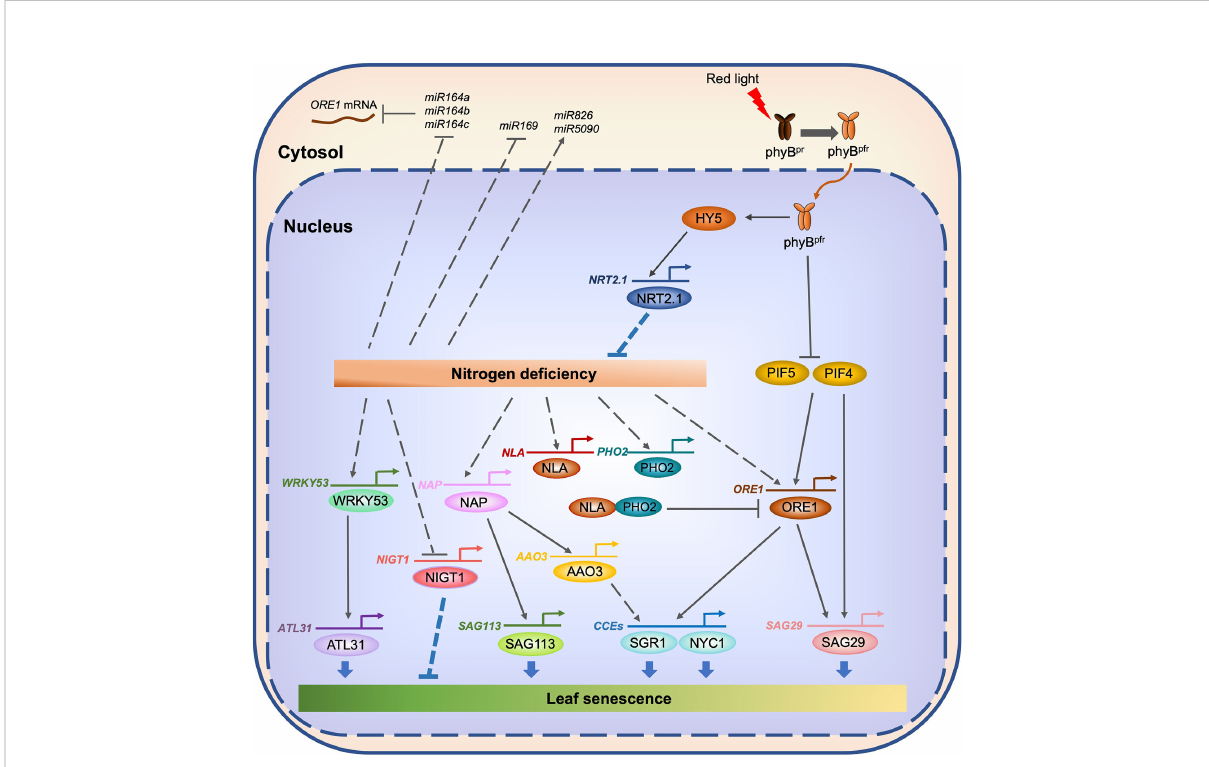
FIGURE 3 Transcriptional regulatory network of N starvation-induced leaf senescence in Arabidopsis. Under N-de fi cient conditions, the expression of several senescence-associated genes, including WRKY53 , NAP , and ORE1 , is enhanced. On the other hand, N de fi ciency downregulates the expression of miR164 , which destabilizes ORE1 mRNA, leading to a further increase of the accumulation of ORE1 protein. WRKY53 directly enhances the expression of ATL31 , a key regulator of high C/low N-induced leaf senescence. NAP directly enhances the expression of SAG113 and AAO3 . ORE1 directly enhances the expression of SAG29 and genes encoding chlorophyll catabolic enzymes (CCEs) including SGR1 and NYC1 . On the other hand, the expression of two genes associated with N de fi ciency responses, NLA and PHO2 , is also enhanced. The NLA and PHO2 proteins promote the ubiquitination of ORE1, which leads to the degradation of ORE1, thus allowing the maintenance of a proper ORE1 protein level during N starvation-induced leaf senescence. phyB-mediated red light signaling may involve the suppression of N starvation- induced leaf senescence. Under the red light, the active Pfr form of phyB moves from cytosol to the nucleus. Under the downstream of phyB, HY5 directly activates the expression of genes associated with N acquisition, including NRT2.1 . On the other hand, phyB promotes the proteasomal degradation of PIF4 and PIF5, which directly activate the expression of several senescence associated genes, including ORE1 and SAG29 . Solid lines indicate direct regulation, while dotted lines indicate indirect